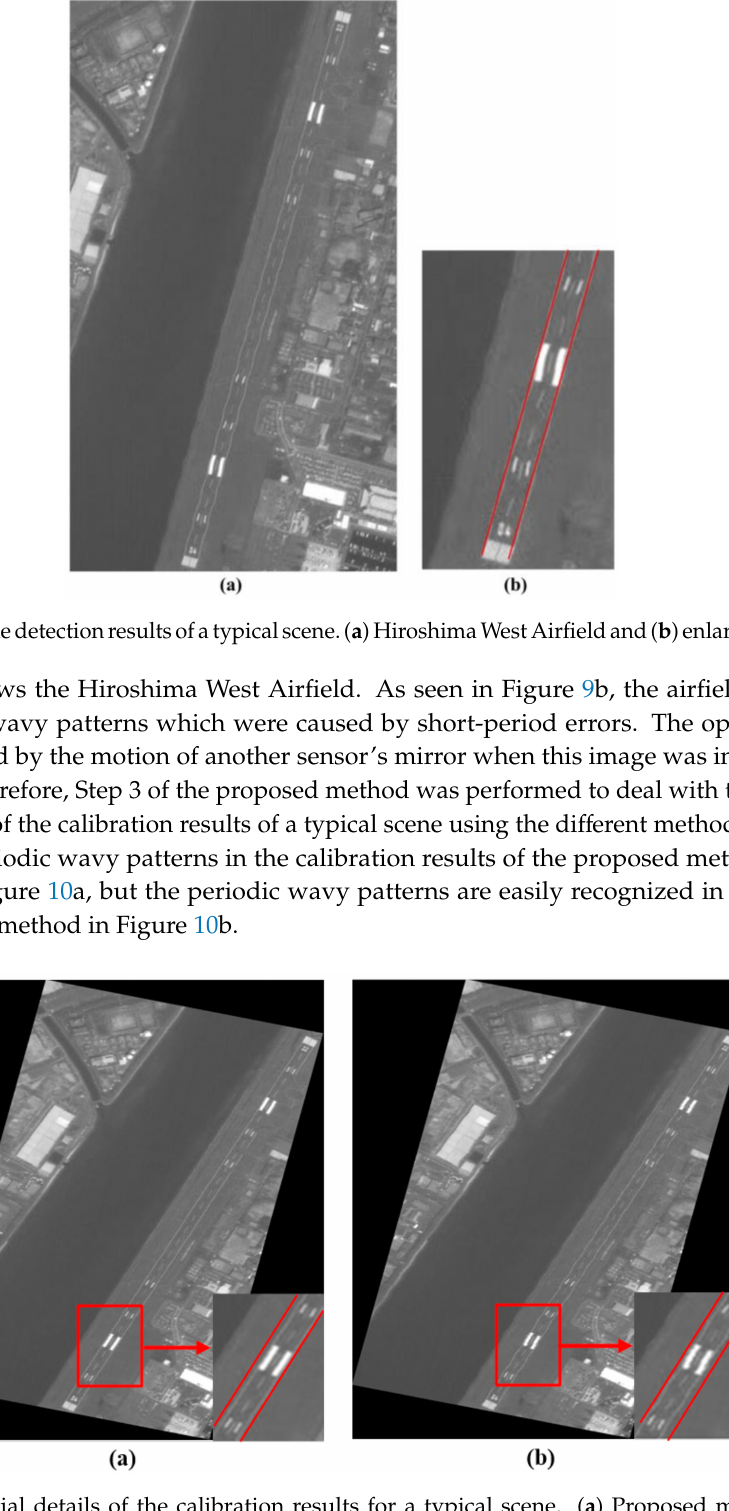
Figure 10. Partial details of the calibration results for a typical scene. ( a ) Proposed method and ( b ) RFM